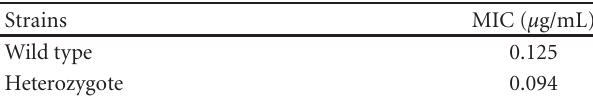
Table 1: Caspofungin susceptibility. The MIC of caspofungin was measured by the E -test method. No significant di ff erence between the wild-type parental and the mutant was